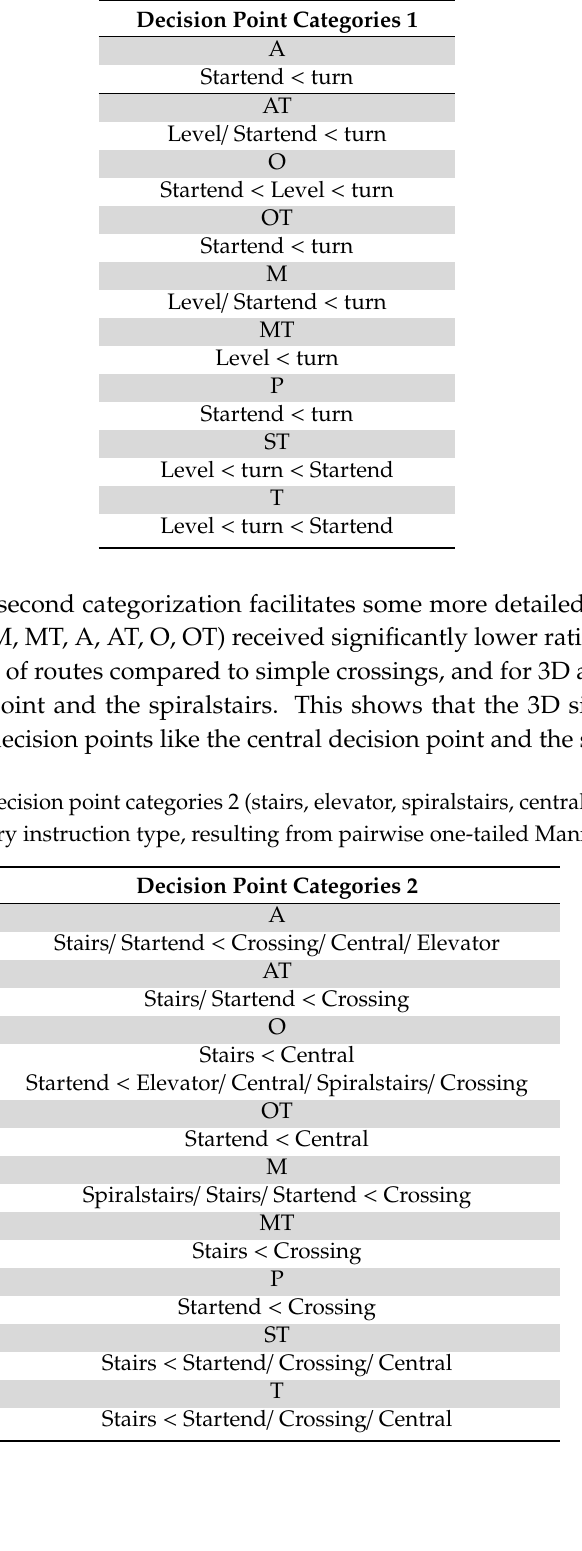
Table 5. Rankings of decision point categories 1 (level, startend, turn) from low to high ratings for every instruction type, resulting from pairwise one-tailed Mann-Whitney U tests.